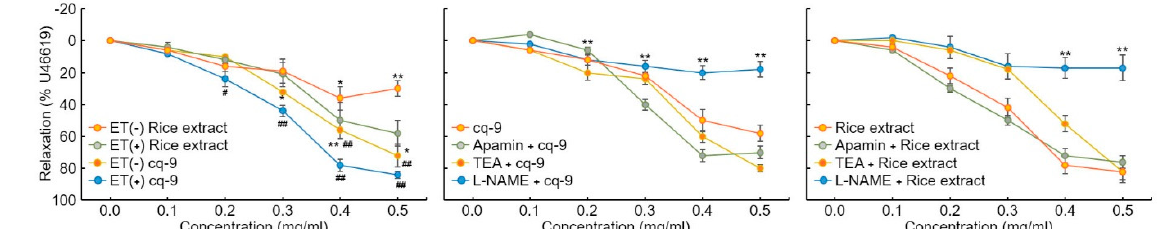
Figure 6. Rice extract or cq-9 reduces vascular contraction in SD rats. Vasorelaxation induced by rice extract or cq-9 in the aorta from rats. Rice extract or cq-9 was added cumulatively to elicit relaxation when vascular contractions induced by U46619 reached a plateau in endothelium-intact (ET+) or -denuded (ET-) rat aortic rings. We investigated the relaxation response by treating endothelium-intact aortic rings with Apamin (500 nM), tetraethylammonium (TEA, 5 nM) and NG- nitro-L-arginine methylester (L-NAME, 100 µM) for 30 min. After U46619 treatment, Rice extract or cq-9 was cumulatively added to the aortic rings. Relaxation is expressed as the percentage of the maximal contraction. * p <0.05, ** p <0.01 vs. Rice extract (ET-) or cq-9 (ET-). # p < 0.05, ## p < 0.01 rice extract vs. cq-9. Data are expressed as the mean ± SE (n = 4).